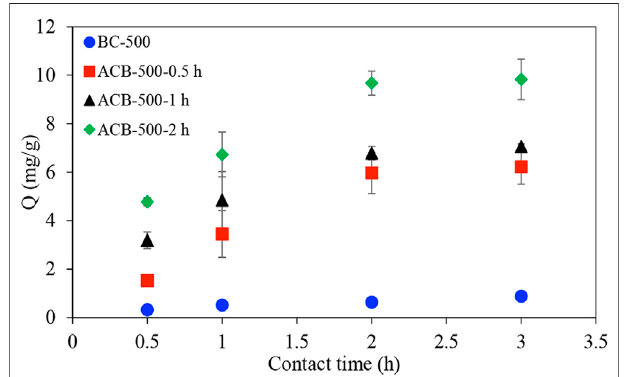
FIGURE 10 | Methyl Orange adsorption pro fi les for four samples: bio- char produced at 500 ° C and three activated bio-chars produced at 900 ° C with activation holding times of0.5, 1, and 2 h 100 ml samples with 250 mg/L of MO concentration to which 1 g of bio-char was added.